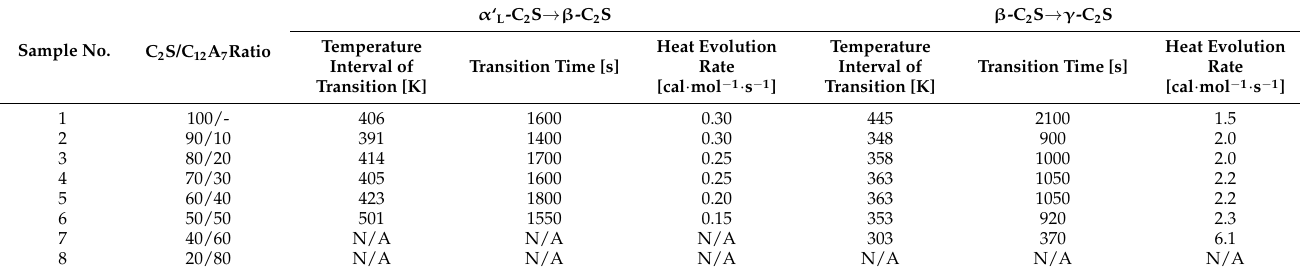
Table 5. Heat evolved during polymorphic transitions (N/A—not applicable, polymorphic transition did not occur). Sample